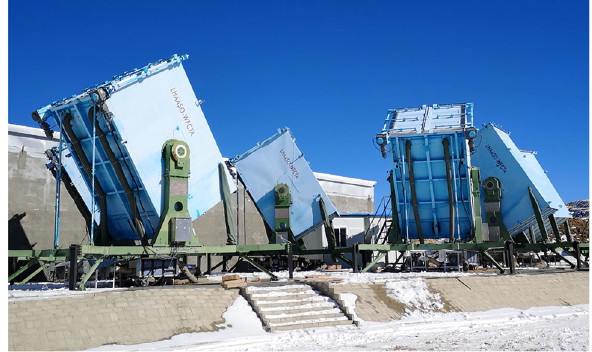
Fig. 1 The photo of six telescopes of WFCTA